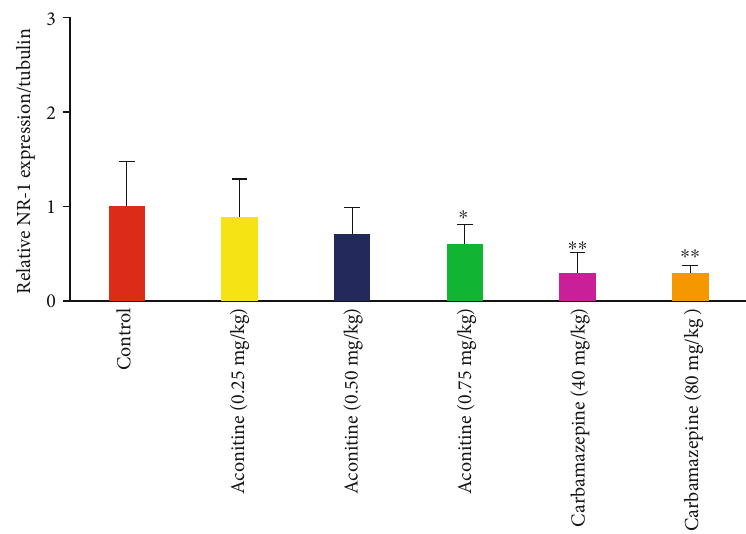
Figure 4: E ff ects of test samples on NR-1 expression in ipsilateral spinal cord in Western blot test.